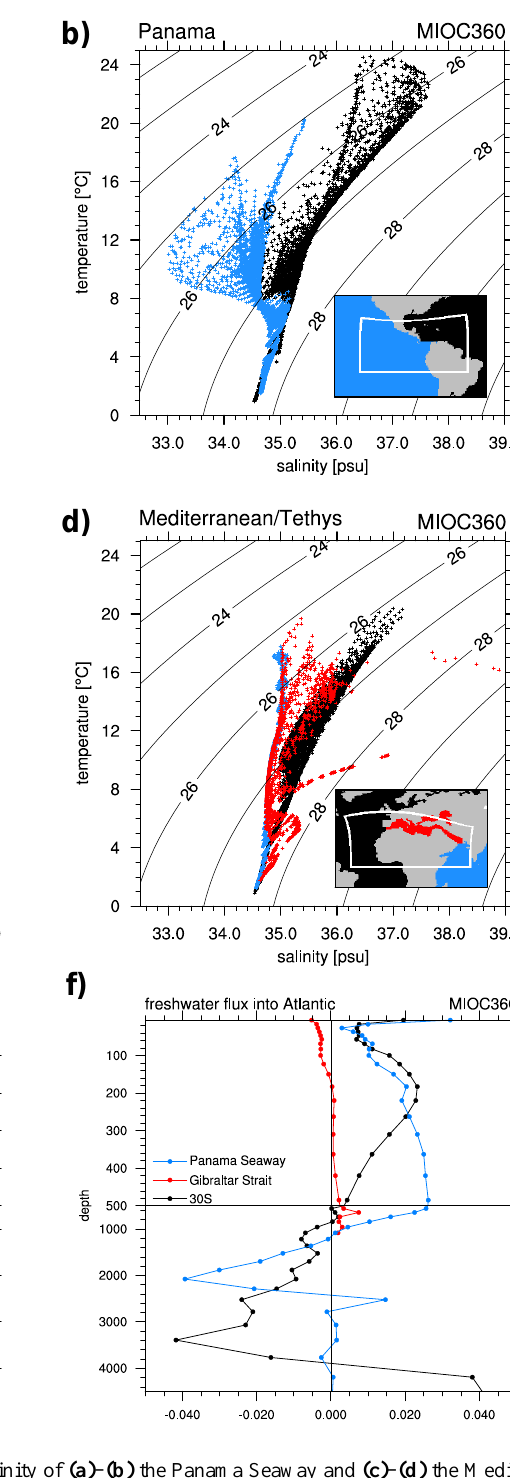
Fig. 12. T-S diagram for the water masses below 150m in the vicinity of (a) – (b) the Panama Seaway and (c) – (d) the Mediterranean/Tethys for CTRL and MIOC360. Black crosses represent Atlantic Ocean water masses, blue crosses Pacific and Indian Ocean water, and red crosses Mediterranean/Tethys water. The in-line plots show the region for which the T-S pairs are obtained. (e) – (f) The freshwater flux through the Panama Seaway (blue), Gibraltar Strait (red), and at 30 ◦ S into the Atlantic Ocean relative to a salinity of 35.5psu. Freshwater flux at each depth is weighted with the corresponding level thickness; the vertical sum equals the total freshwater flux. Note the different tickmarks for the upper